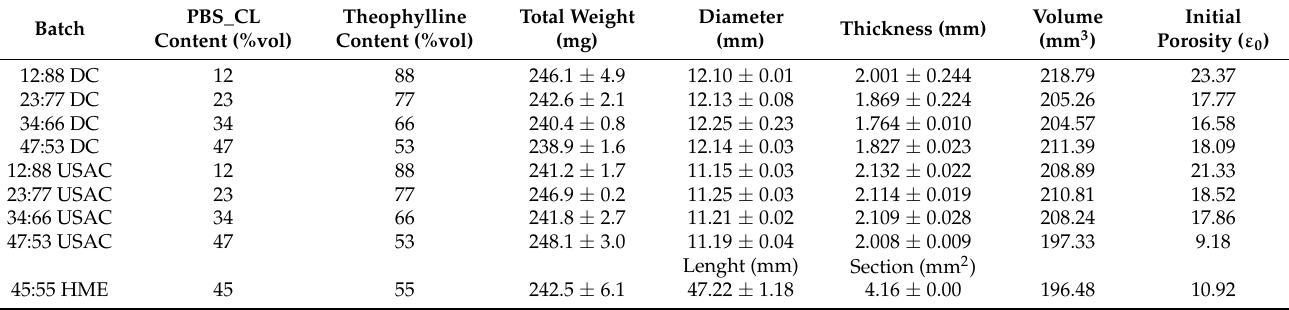
Table 1. Dimensions of PBS_CL tablets obtained by DC and USAC and HME